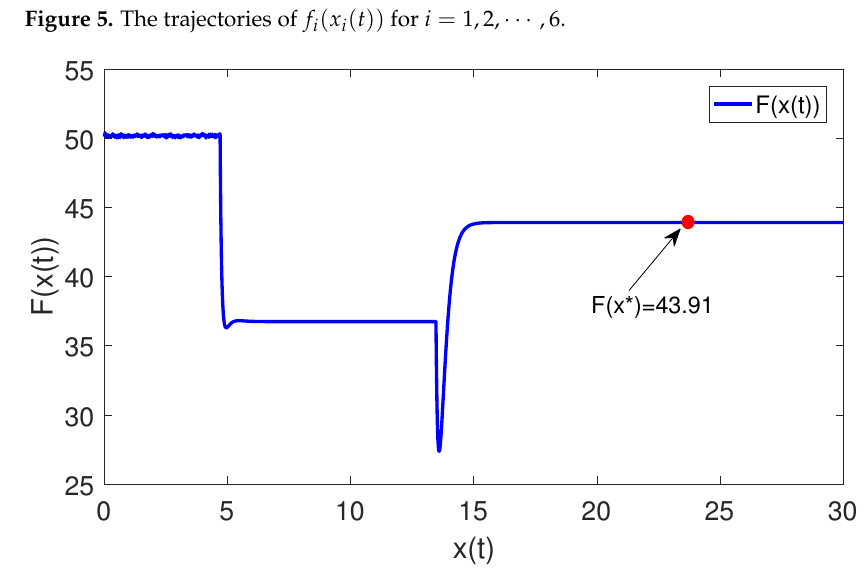
Figure 6. The trajectory of F ( x ( t )) .